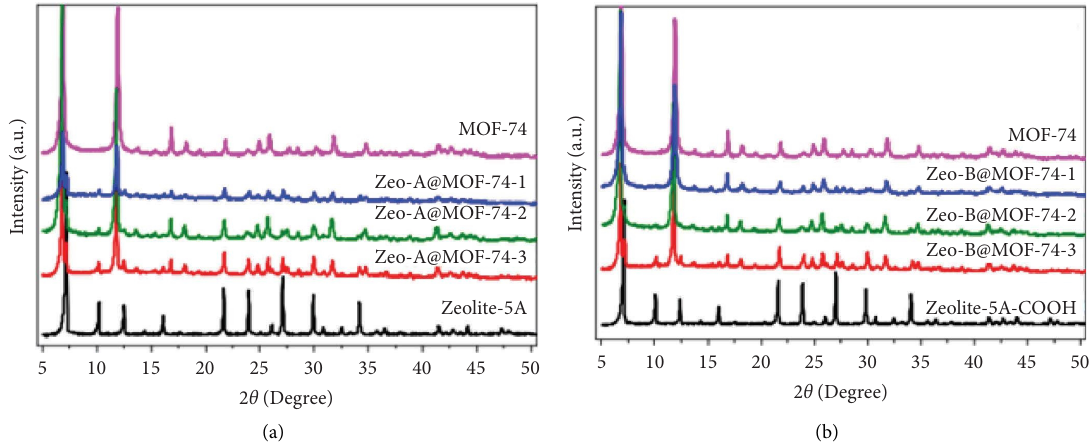
Figure 19: Te XRD results for (a) zeolite-5A and (b) zeolite-5A-COOH based composites adopted from [41].